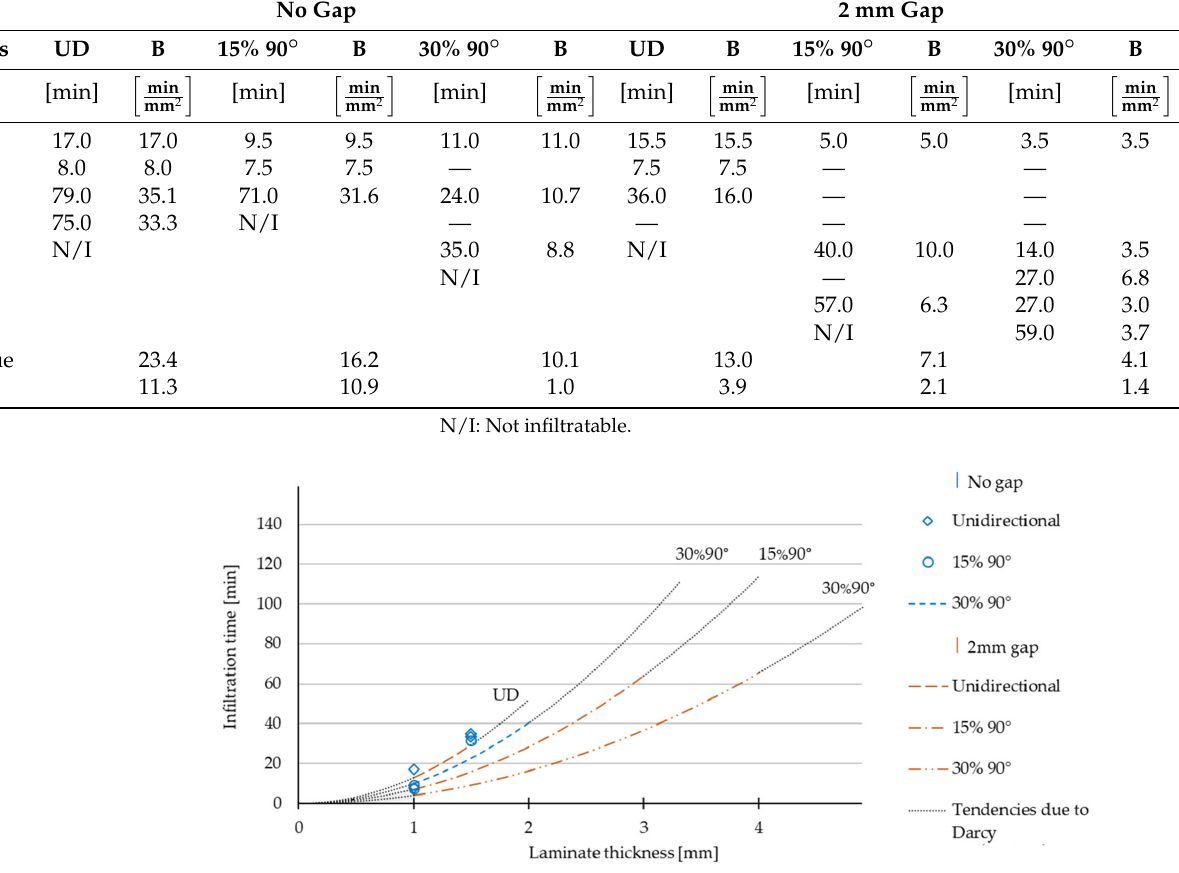
Figure 11. Infiltration times due to ply configuration, curves calculated by formula (2), based on the average B-factors of the different configurations in Table